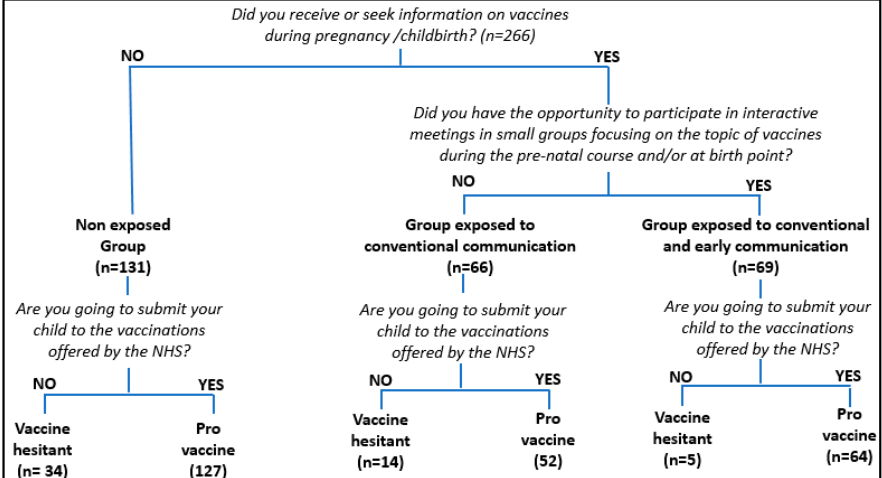
Figure 1. Interview process and data extraction process.